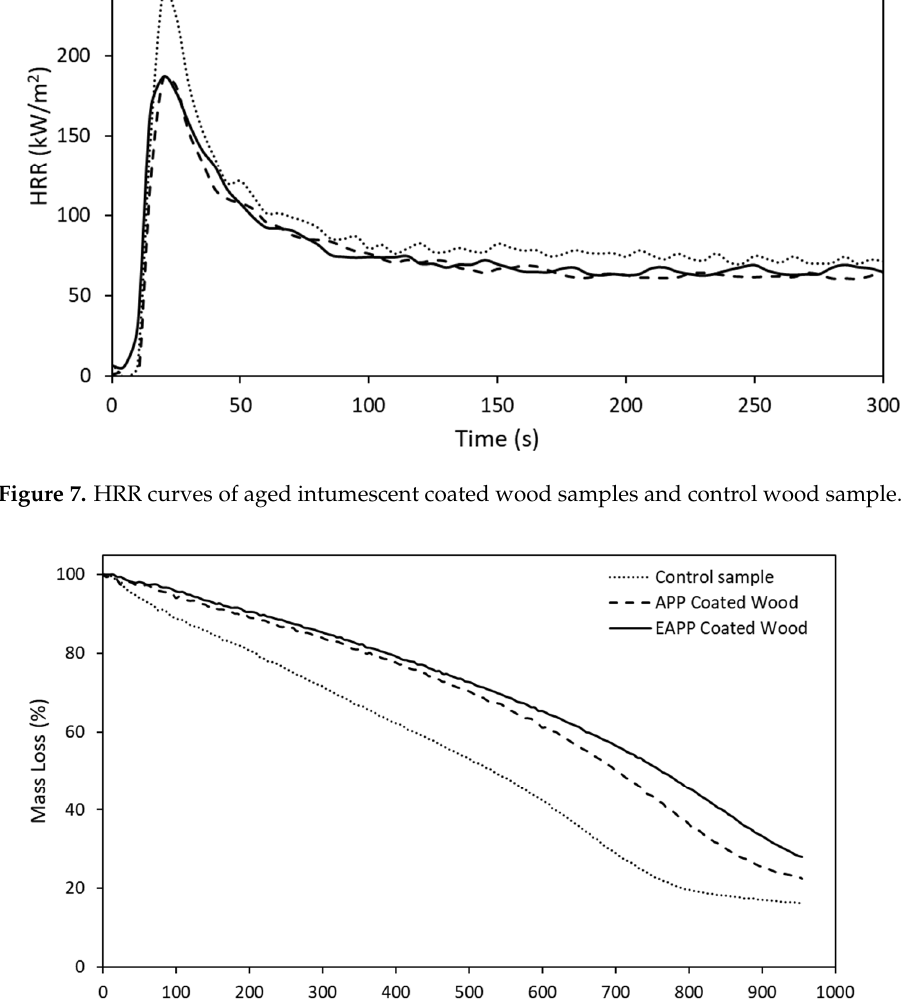
Figure 7. HRR curves of aged intumescent coated wood samples and control wood sample.